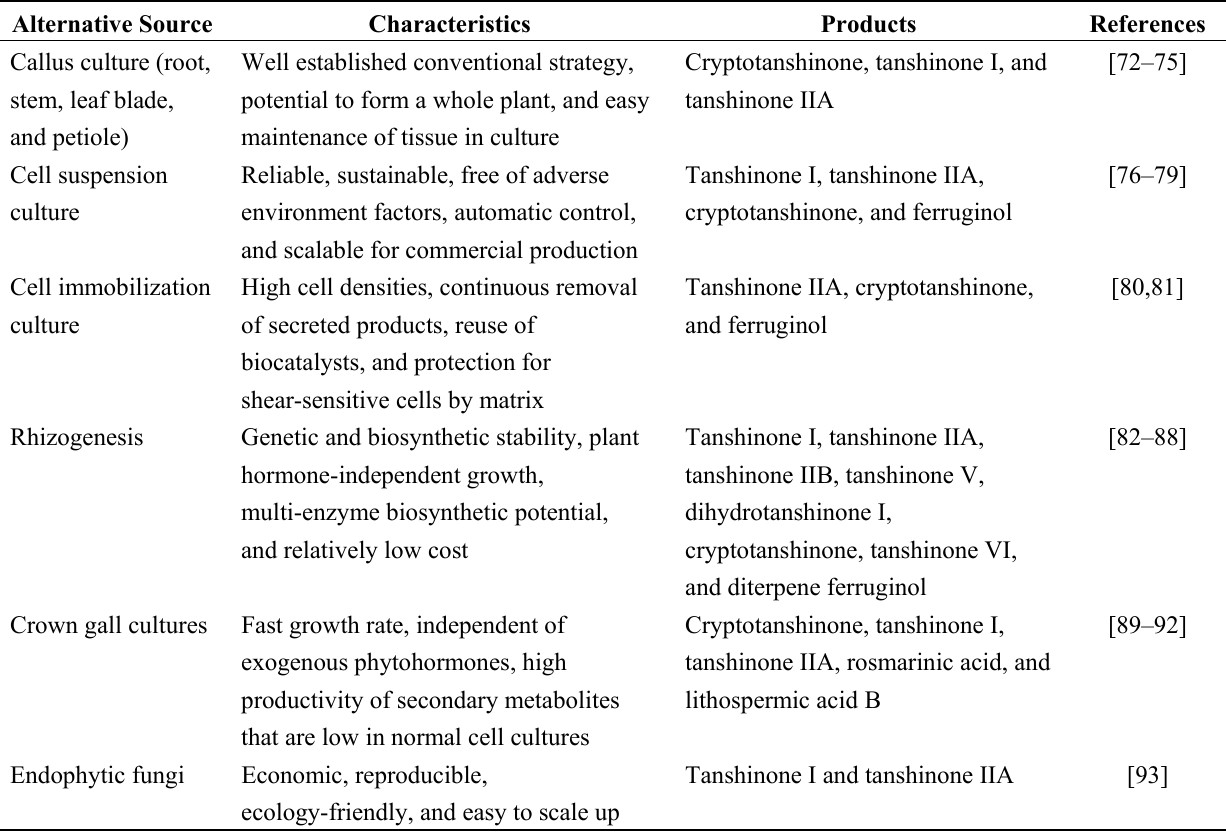
Table 1. Alternative sources of S. miltiorrhiza and tanshinone